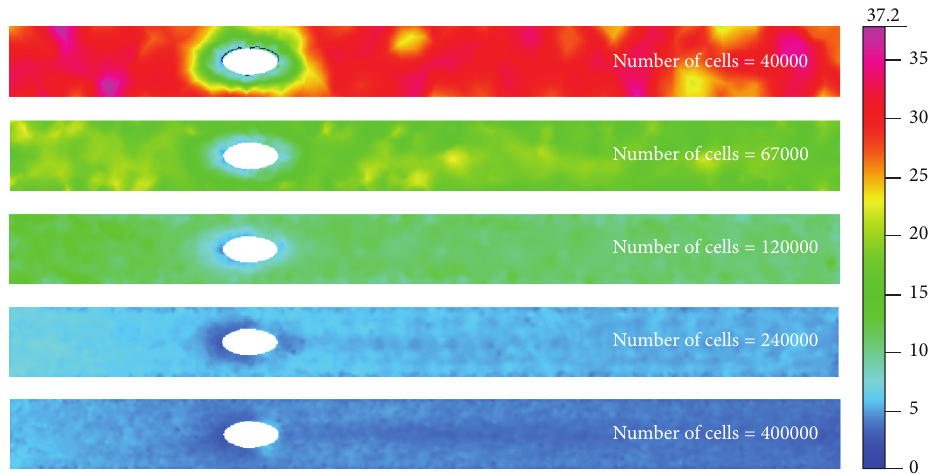
Figure 10: Contours of 𝑦 + on the wall for different numbers of grid